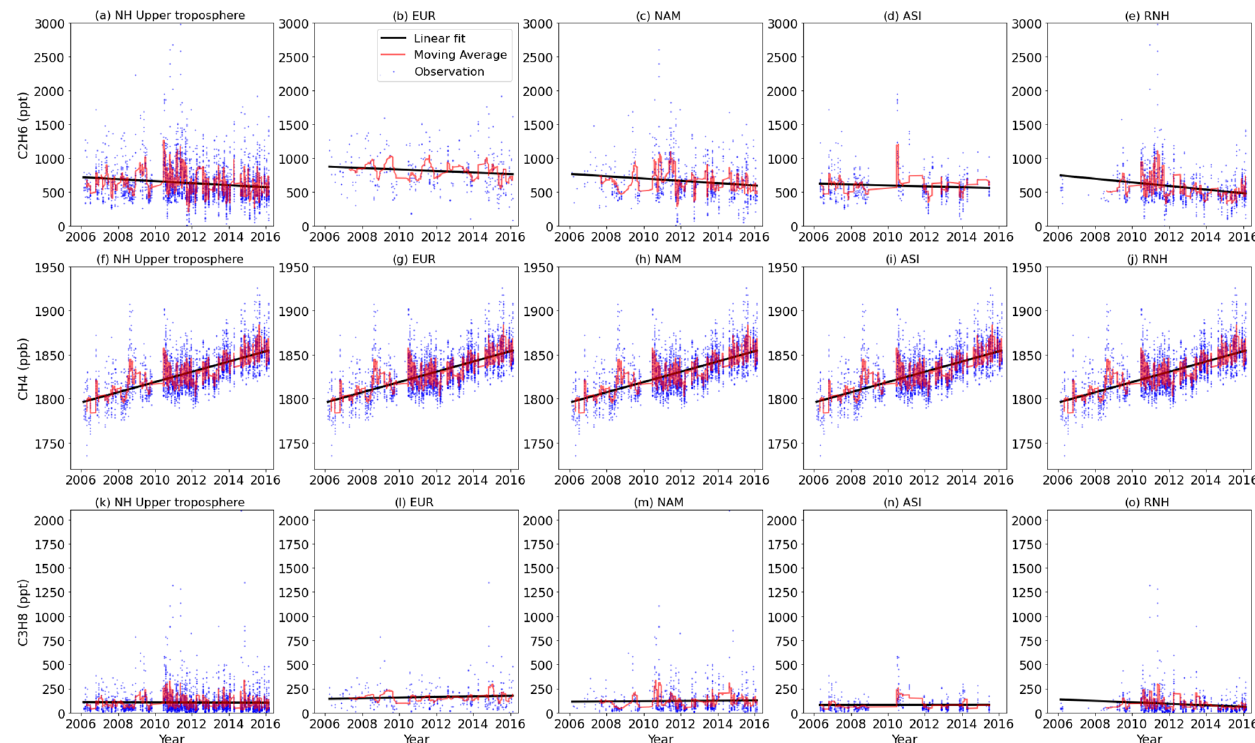
Figure 2. The upper tropospheric ethane, methane and propane mole fractions from observations and linear trends over five regions, whole NH upper troposphere, EUR, NAM, ASI, and